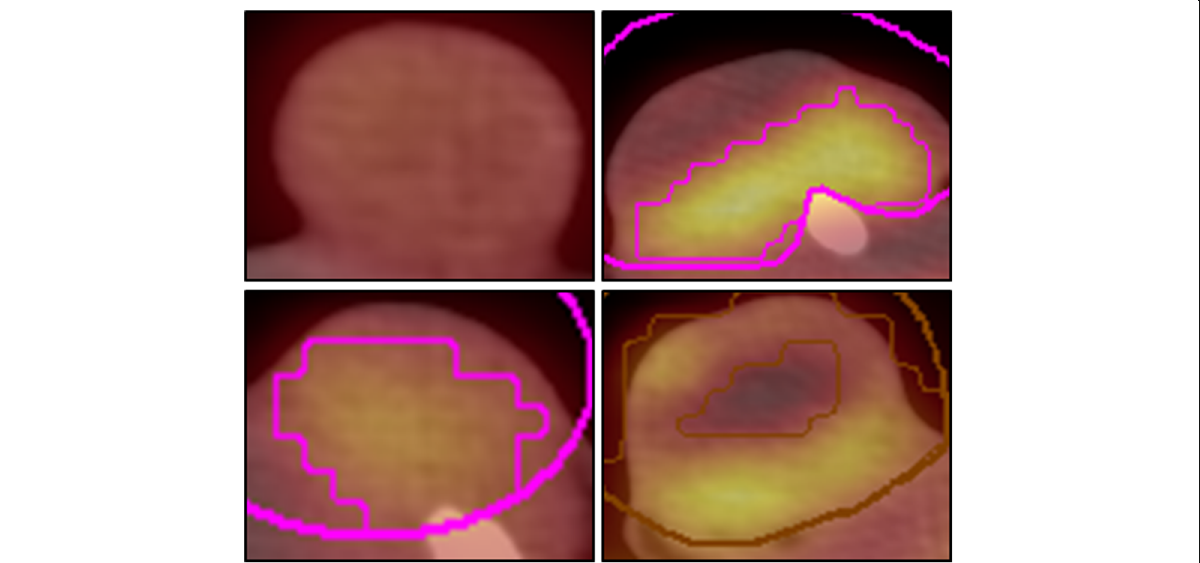
Fig. 3 Imaging tumors with [18F]FDG-PET/CT. The upper and lower rows depict images from cell line A549 and H1299, respectively; the left and right columns depict images for non-co-transplanted and co-transplanted tumors, respectively. Left column: lower activity with homogenous pattern of [18F]FDG-activity in non-co-transplanted tumors; right column: in contrast higher activity with heterogeneous pattern of [18F]FDG-activity in co-transplanted